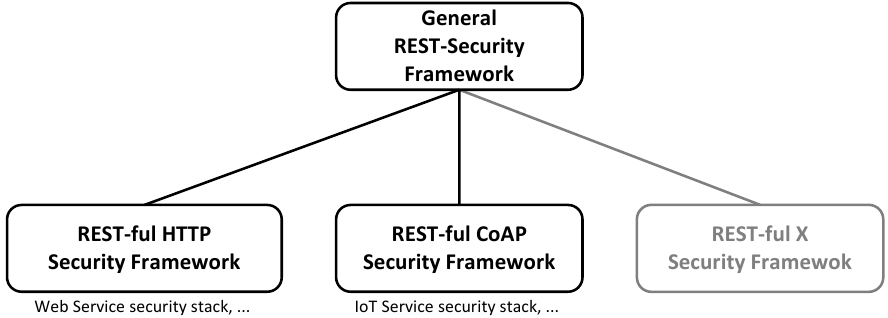
Figure 6. Instantiation of the general REST-security framework to specific REST-ful protocols.